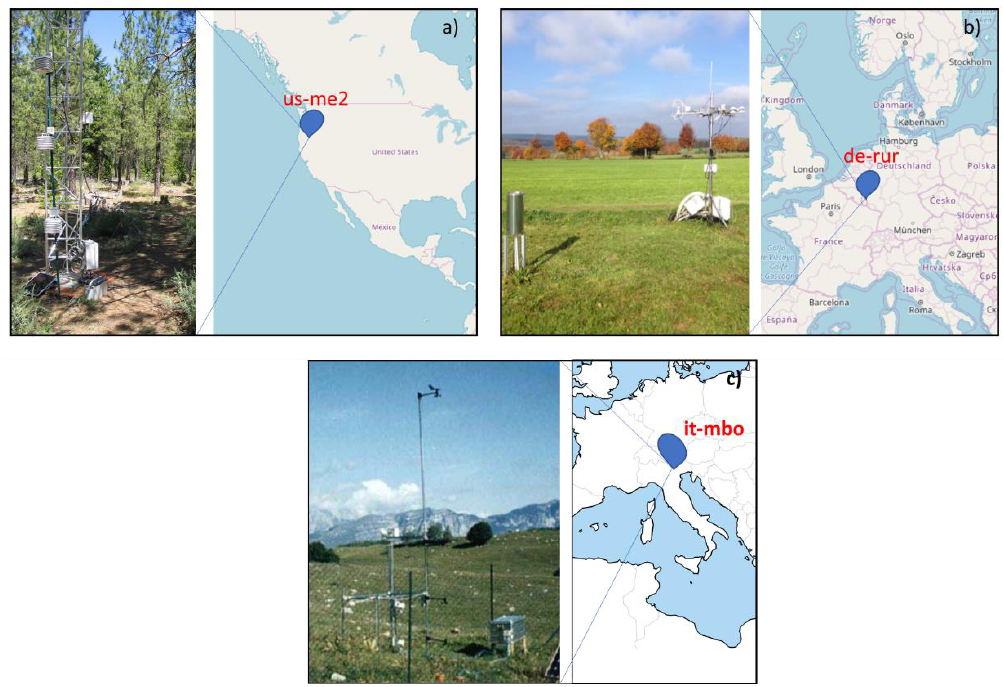
Figure 1. Experimental sites location. Sister site ( a ), Rollesbroich site ( b ), Bondone Mountain site ( c ).